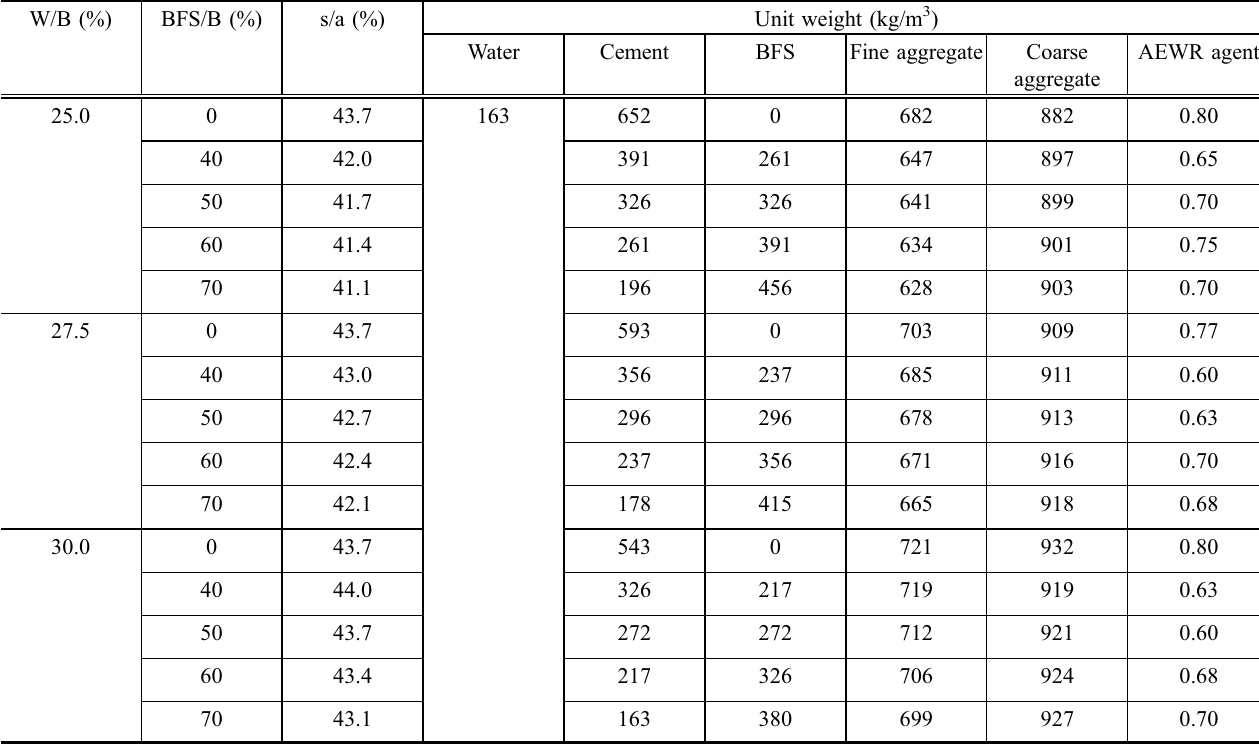
Table 1 Mixture proportions.